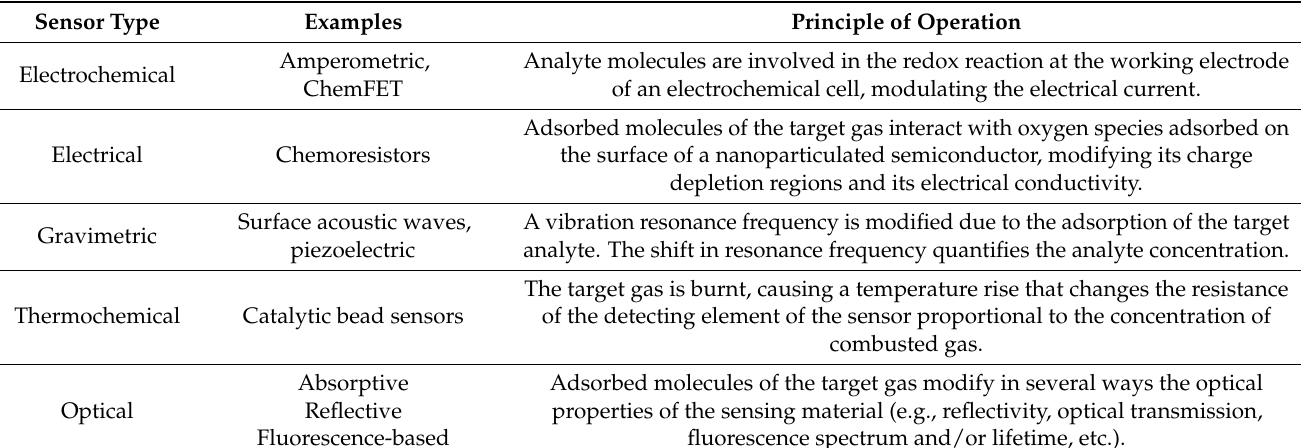
Table 1. Types of sensor devices and their principle of